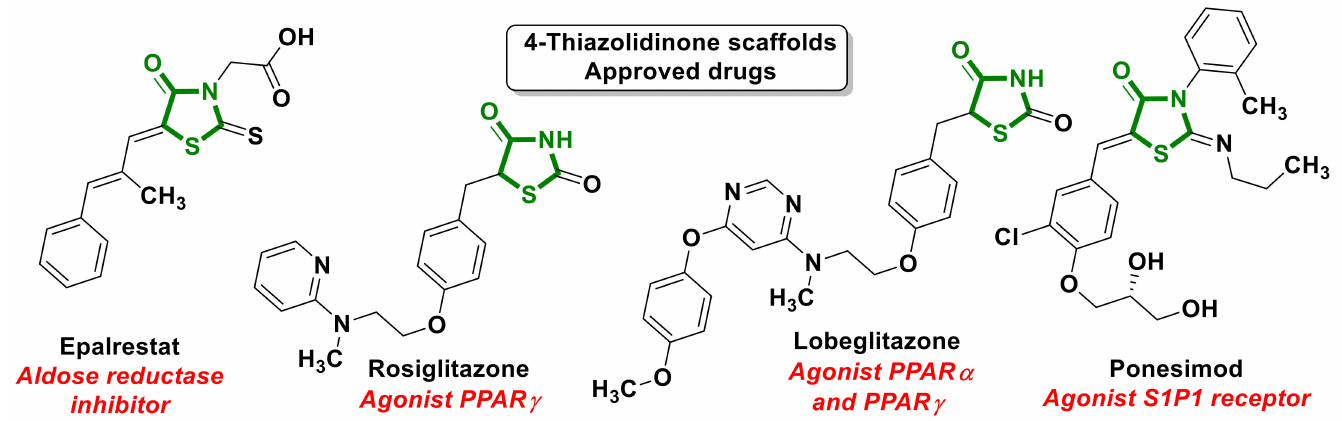
Figure 1. The profile of 4-thiazolidinone-bearing molecules in medicinal chemistry. 4-Thiazolidinone scaffolds are widely used for the development of anticancer